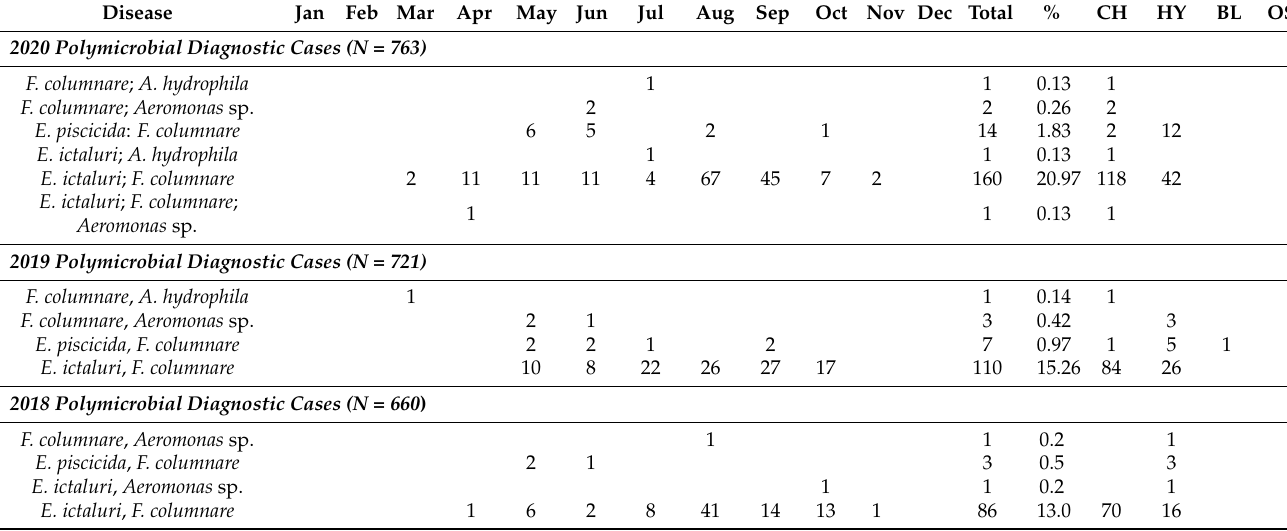
Table 3. Mississippi State University—College of Veterinary Medicine Aquatic Research and Diagnostic Laboratory, Stoneville; MS Polymicrobial cases from 2016 to 2020. Disease diagnosis as a percentage of total case submissions. CH = Channel catfish, HY = hybrid catfish, BL = blue catfish, OS = Other